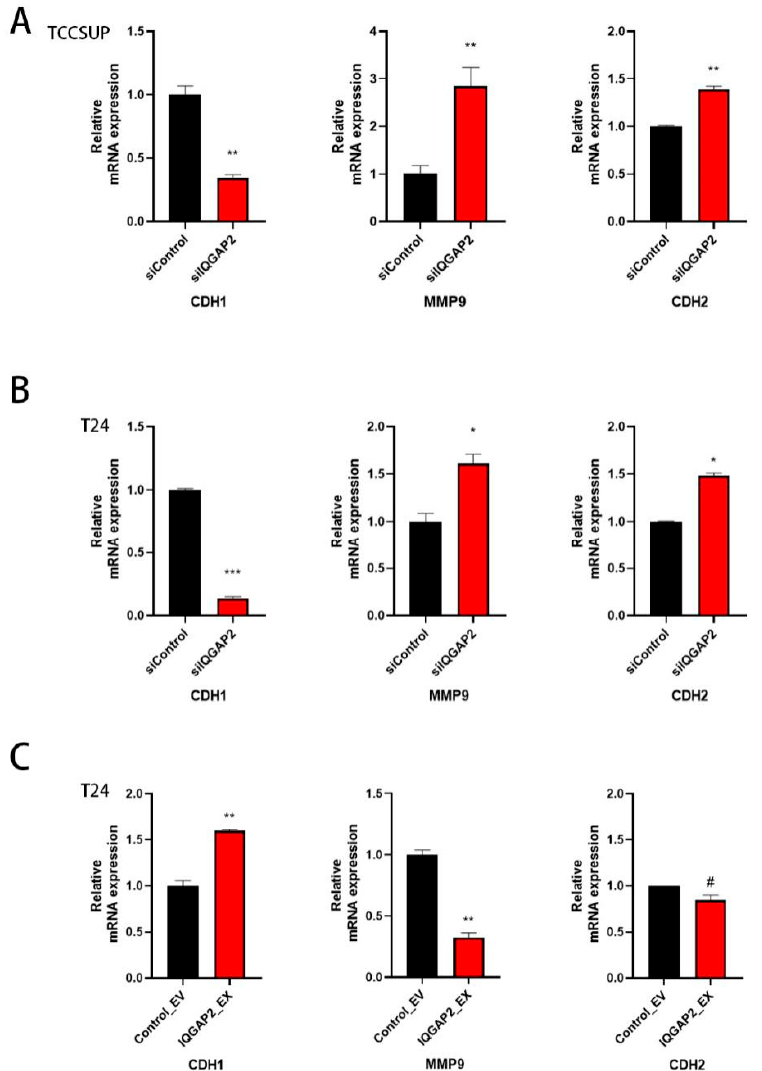
Figure 5. IQGAP2 expression levels showed effects on EMT markers. qPCR showed elevated expressions of MMP9 and CDH2 and a reduced expression of CDH1 in TCCSUP ( A ) and T24 ( B ) with IQGAP2 knockdown (siIQGAP2) compared to control (siControl). qPCR show reduced expression of MMP9 and elevated expression of CDH1 in T24 ( C ) with IQGAP2 overexpression (IQGAP2_EX) compared to control (Control_EV). Bar chart presents the means of replicates ± SEM from three different experiments; Student’s t-test (two-tailed, unpaired) was used for comparison of means; # indicates p > 0.05; * p ≤ 0.05, ** p ≤ 0.01, and *** p ≤ 0.001.